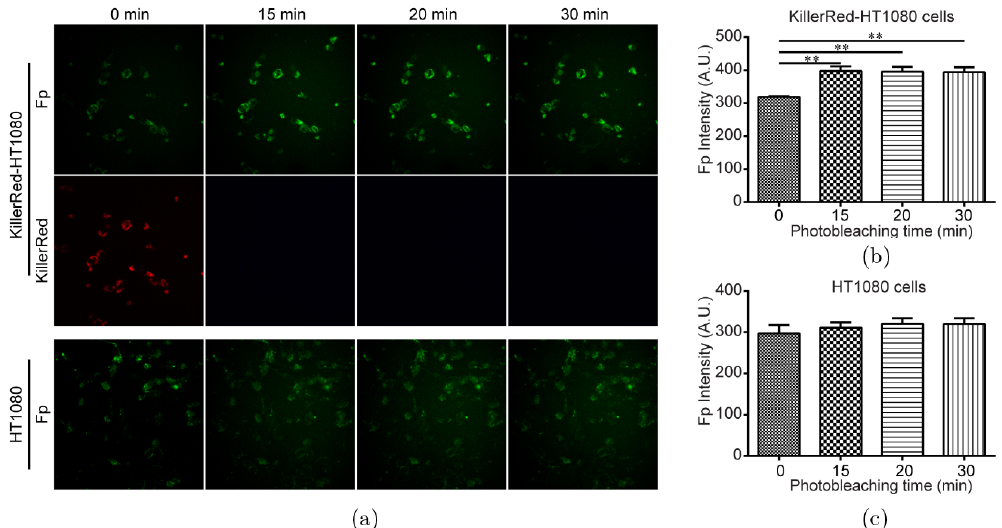
Fig. 2. Auto°uorescence and KillerRed °uorescence after green light irradiation. (a) The °avoprotein °uorescence intensities of HT1080 cells and KillerRed-HT1080 cells under the irradiation by 561 nm laser for 0 min, 15 min, 20 min, and 30 min. The ¯rst row: the Fp images of KillerRed-HT1080 cells. The middle row: the KillerRed °uorescent images of KillerRed-HT1080 cells. The third row: the Fp images of the HT1080 cells. (b) The quantitative °uorescence intensity analysis of KillerRed-HT1080 cells. (c) The